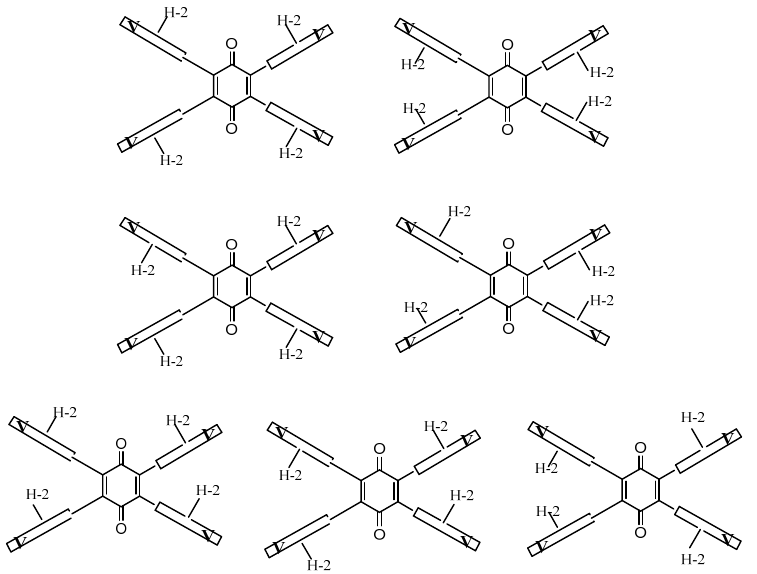
Figure A3 . Representation of the seven isomers of tetra-adduct 8 . Figure A3. Representation of the seven isomers of tetra-adduct 8